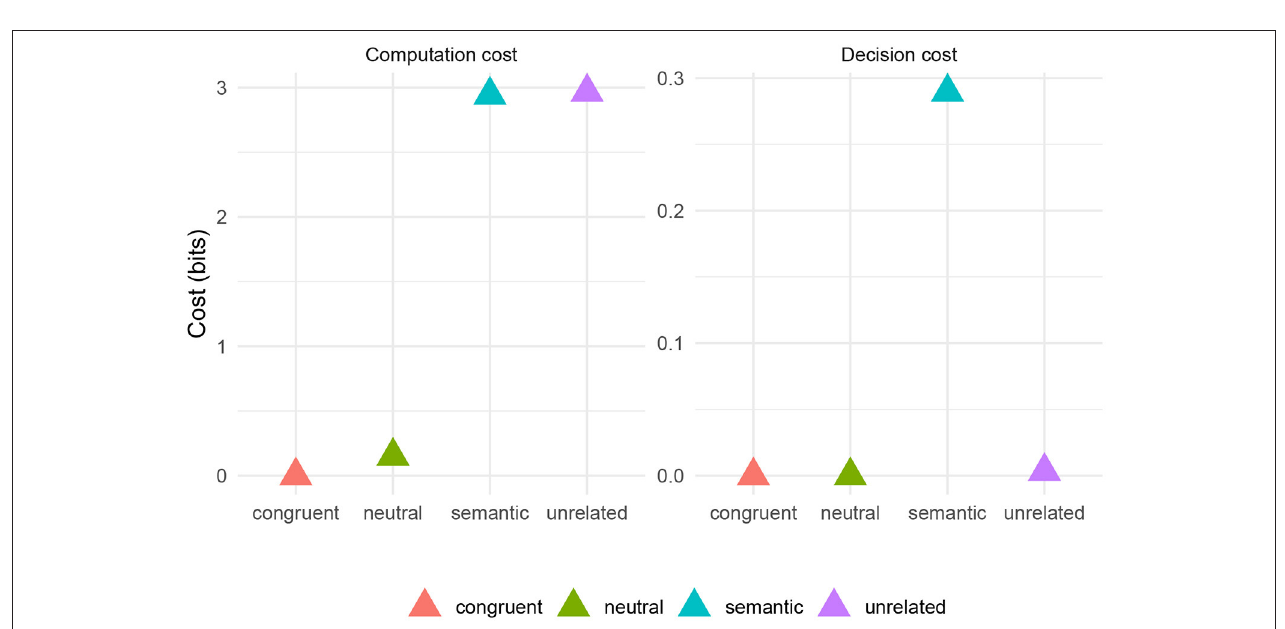
FIGURE 8 | Simulated costs by PWI task condition based on materials from Roelofs and Piai (2017) and fastText word embeddings.